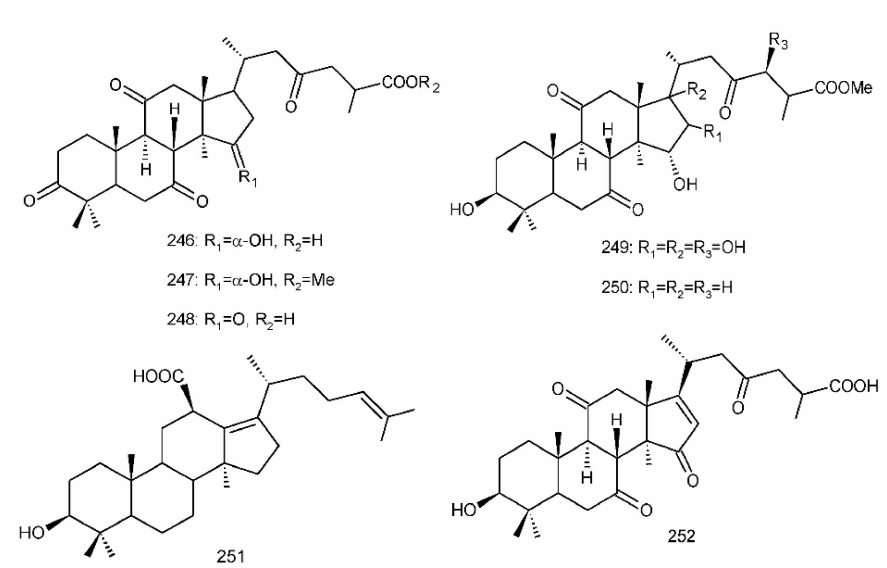
Figure 5. Chemical structures of several 8,9-dihydro-triterpenoids ( 246 – 252 ).